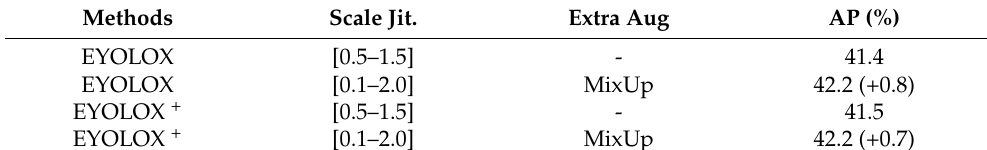
Table 3. Comparison of different augmentation strategies in EYOLOX. “Scale Jit.” stands for the range of scale jittering for mosaic image. The “+” stands for the expensive operation mentioned above.